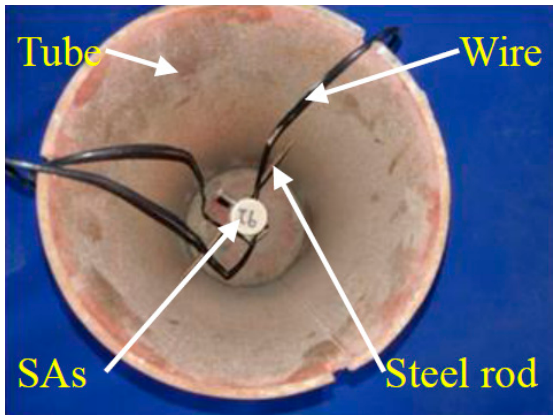
Figure 10. The placement of smart aggregates.